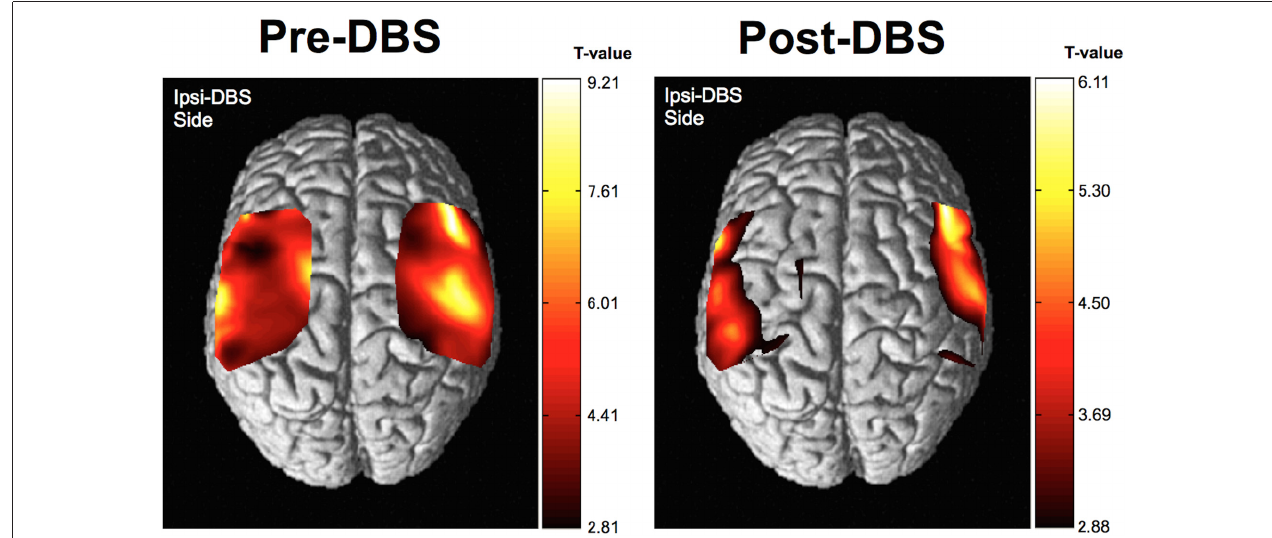
GPI DBS, based on a 6-month follow-up of clinical